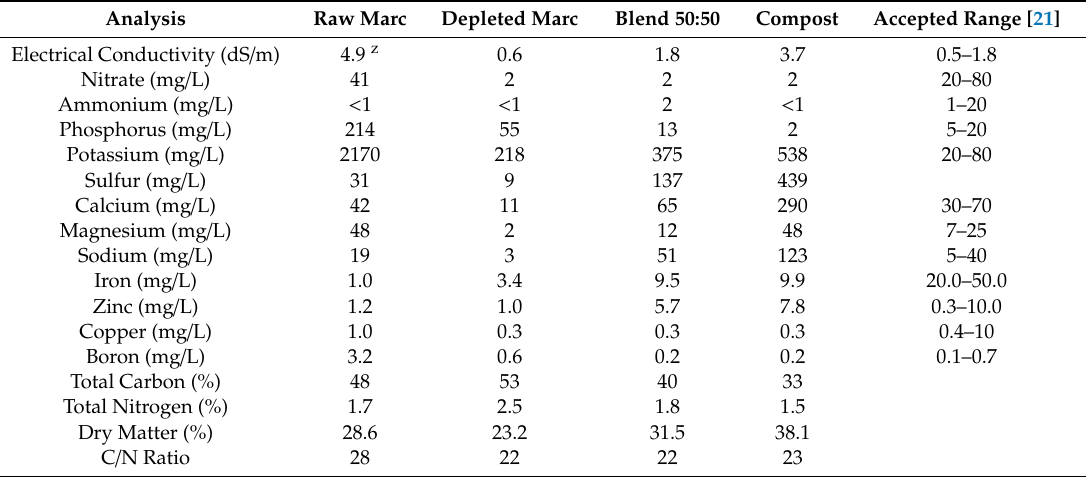
Table 3. Nutrient profiles of grape marc and growing media used in the seedling emergence